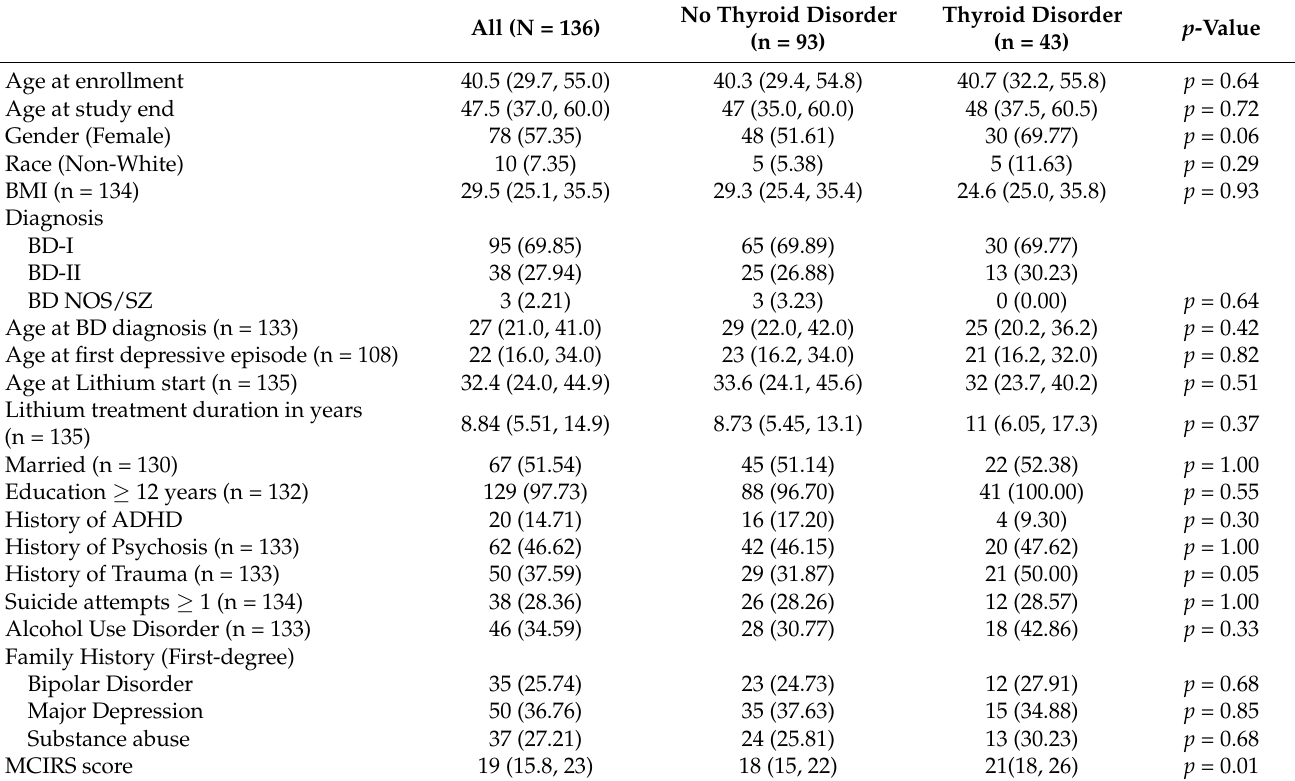
Table 1. Study population characteristics, reported as Median (Q1, Q3) or N (%). All (N = 136)